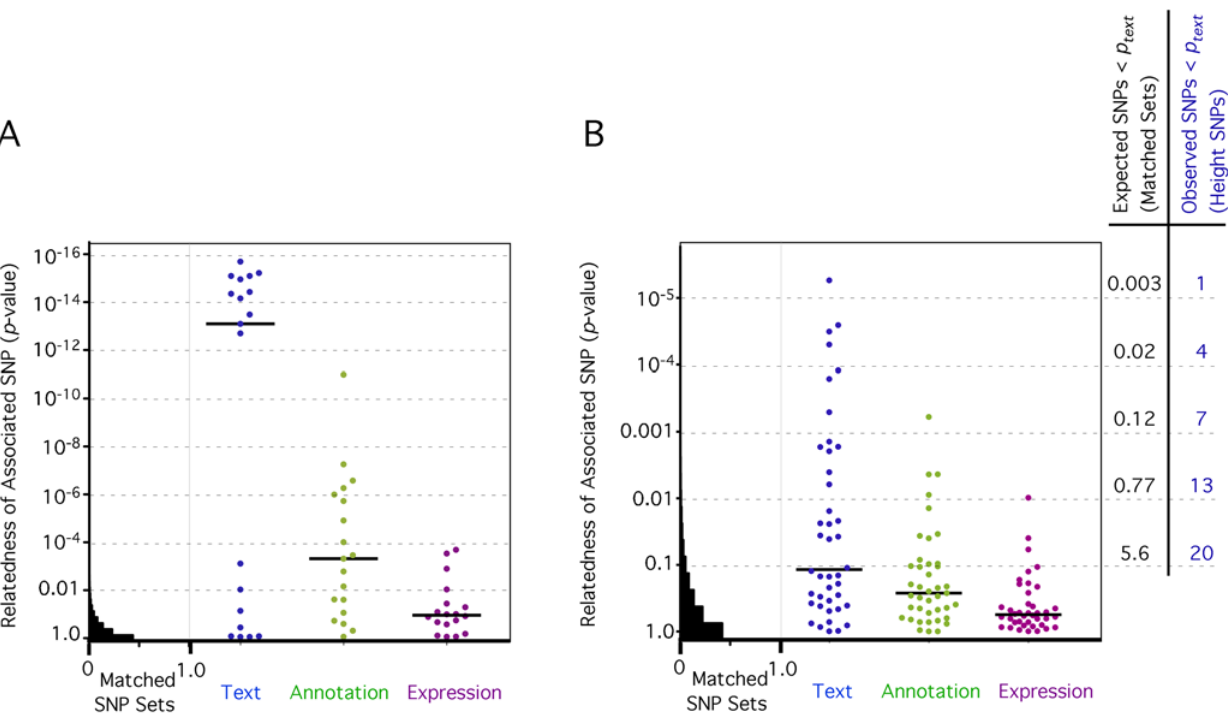
Figure 2. SNPs associated with lipid metabolism and height contain genes related to each other. (A) 19 SNPs associated with lipid metabolism. The y -axis plots the p text values on a log scale, with increasing significance at the top. The histogram on the left side of the graph illustrates values for matched SNP sets. 88.6% of those SNPs have p text values that are . 0.1. The scatter plot on the right illustrates p text values for actual serum cholesterol associated SNPs (blue dots). Black horizontal line marks the median p text value. We assessed the same SNP with similarity metrics based on gene annotation (green dots) and gene expression correlation (purple dots). (B) 42 SNPs associated with height. Similar plot for 42 height associated SNPs. The histogram on the left of the graph illustrates p text values for random SNP sets carefully matched to height-associated SNP set. 86.5% of those SNPs have p text values that are . 0.1. The scatter plot on the right illustrates p text values for actual SNPs associated with height (blue dots). Black horizontal line marks the median p text value. We assessed the same SNP with similarity metrics based on gene annotation (green dots) and gene expression correlation (purple dots). On the right we list for each p text threshold the number of expected SNPs less than the threshold based on matched sets, and the number of observed SNPs less than the threshold among height associated